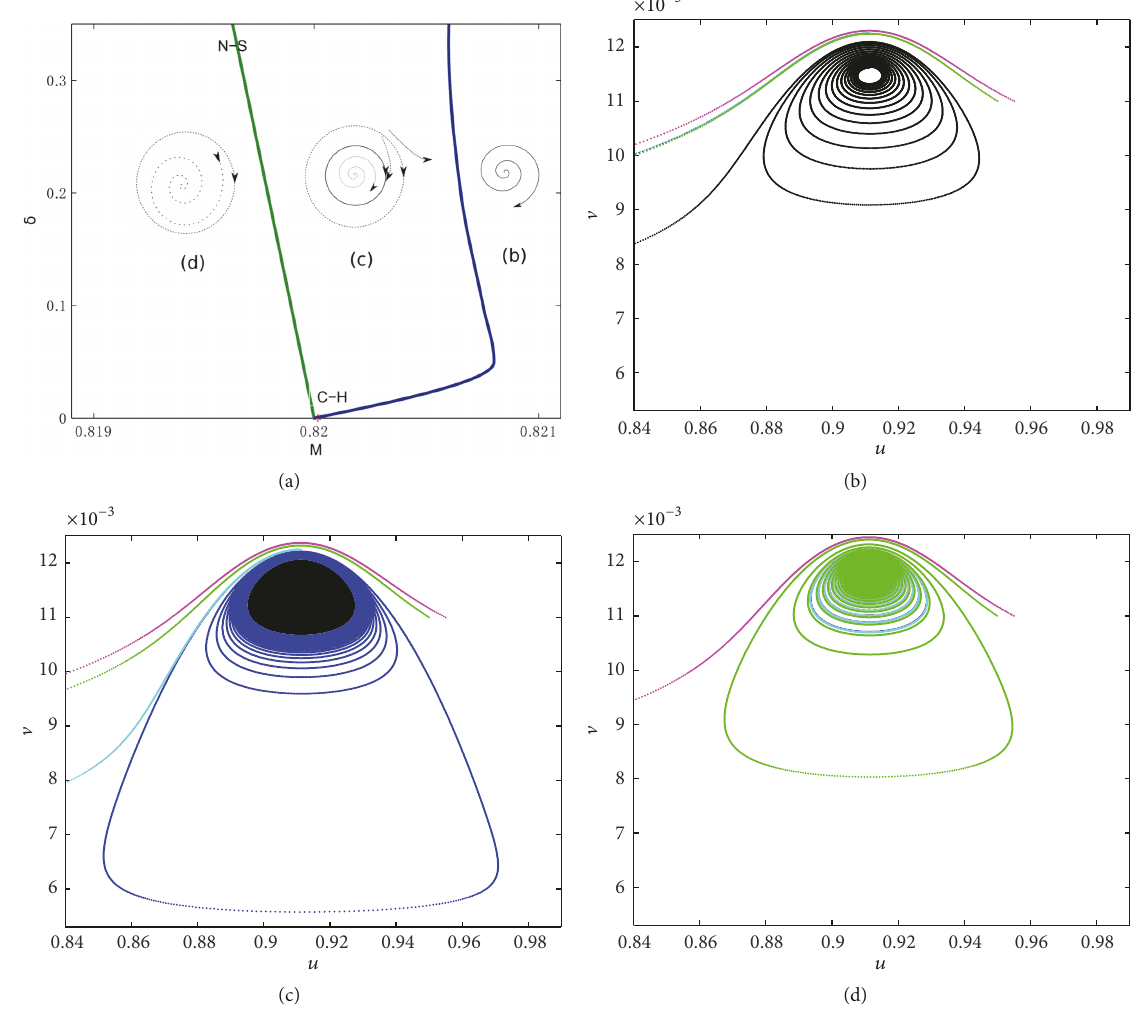
Figure 4: Parameters are 𝐴 = 0.4762, 𝐵 = 0.0689, 𝐶 = 0.9112 , the initial values are (0.9112, 0.01162) , (0.9112, 0.012247) , (0.9112, 0.012249), (0.95, 0.011),(0.955, 0.011) , (a) the bifurcation diagram in (𝛿 - 𝑀) plane [7], (b) 𝛿 = 0.3, 𝑀 = 0.821 , the equilibrium point is unstable, (c) 𝛿 = 0.3, 𝑀 = 0.81999 , the equilibrium point is unstable, two invariant closed curves emerge from the equilibrium point, the larger circle is unstable, and the smaller one is stable, and (d) 𝛿 = 0.3, 𝑀 = 0.819 , the equilibrium point is stable and the smaller circle